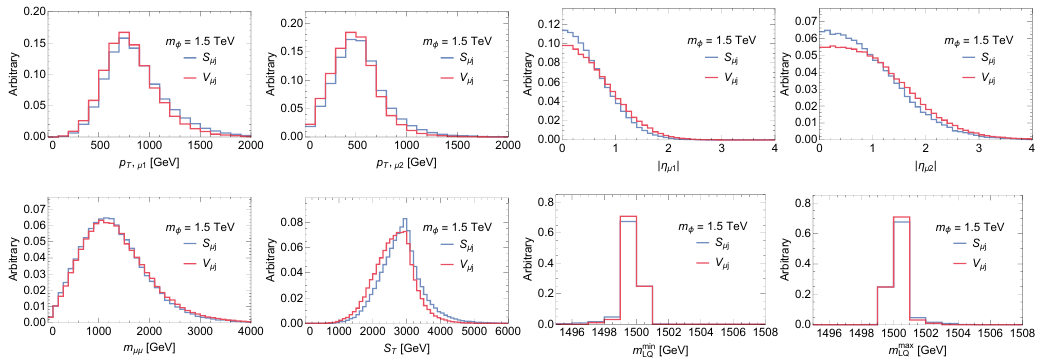
Figure 18 . Same as (cid:12)gure 17 for leptoquarks with mass m